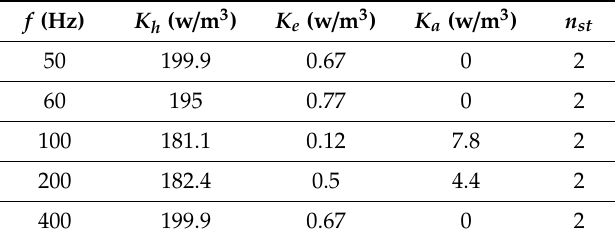
Table 3. Core loss coe ffi cient based on curve